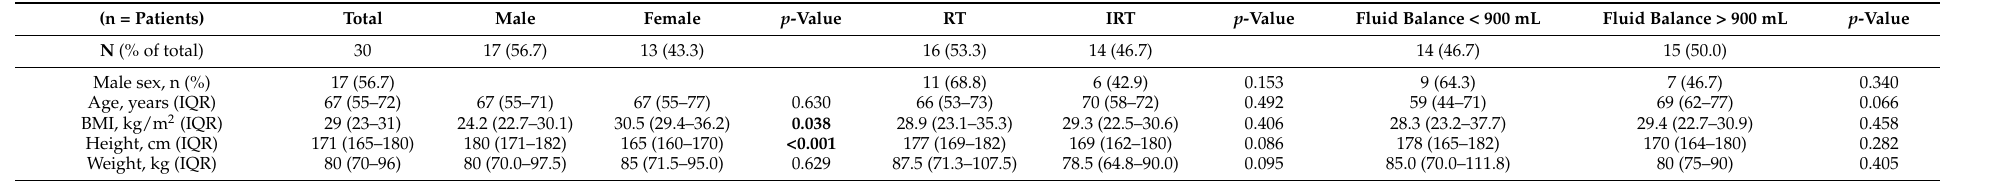
Figure 4. Hemodynamic profiles ( A ) five minutes pre- and post-Landiolol bolus application, ( B ) 15 min pre- and post-, and ( C ) 60 min pre- and 90 min post-, respectively. Table 1. Patients’ basic demographics, overall and stratified in terms of gender. The fluid balance accounts for the overall balance right before push-dose Landiolol application. “IRT” and “RT” concerns the heart rhythm before bolus application. Categorical data are presented as counts and percentages, and continuous data as medians and interquartile ranges (IQRs). Categorical data were analyzed using a test for linear association (Mantel–Haenszel chi-square test) or Fisher’s exact test, and continuous data using Kruskal–Wallis test for testing within the subgroups. Wilcoxon rank test was used for analyzing blood pressure and heart rate changes. RT = regular tachycardia, IRT = irregular tachycardia, BMI = body mass index; AHTN = arterial hypertension; HLP = hyperlipidemia; DM = diabetes mellitus; CAD = coronary artery disease; CKI = chronic kidney injury; PAD = peripheral arterial disease; AF = atrial fibrillation; AFL = atrial flutter; CPR = cardiopulmonary resuscitation; COVID = coronavirus disease; ICU = intensive care unit.